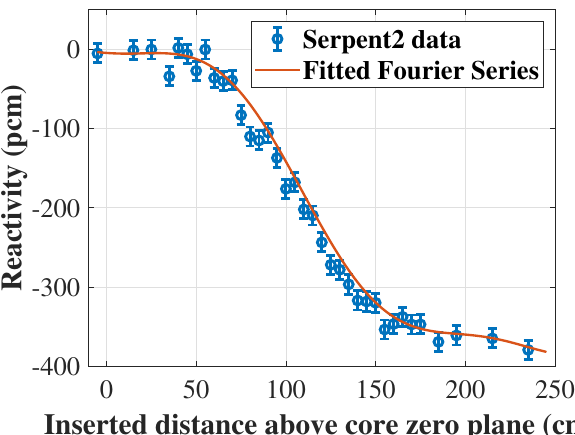
Figure 3: ARC S-curve along with fitted Fourier series function within studied